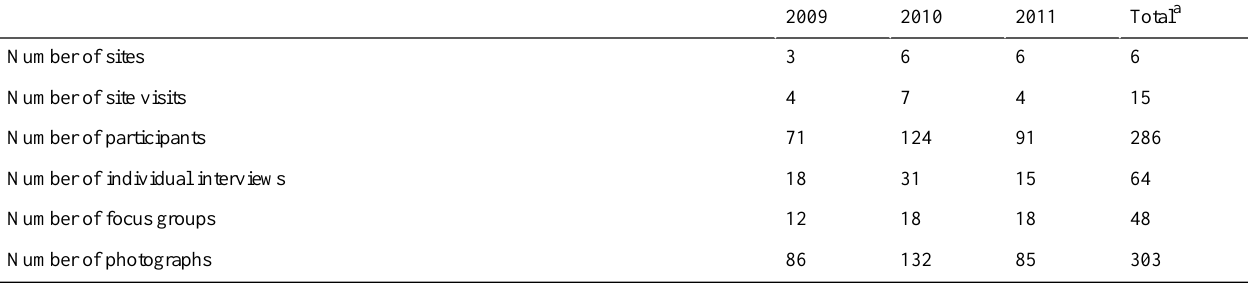
Table 4. Sample size for Tier 3 site